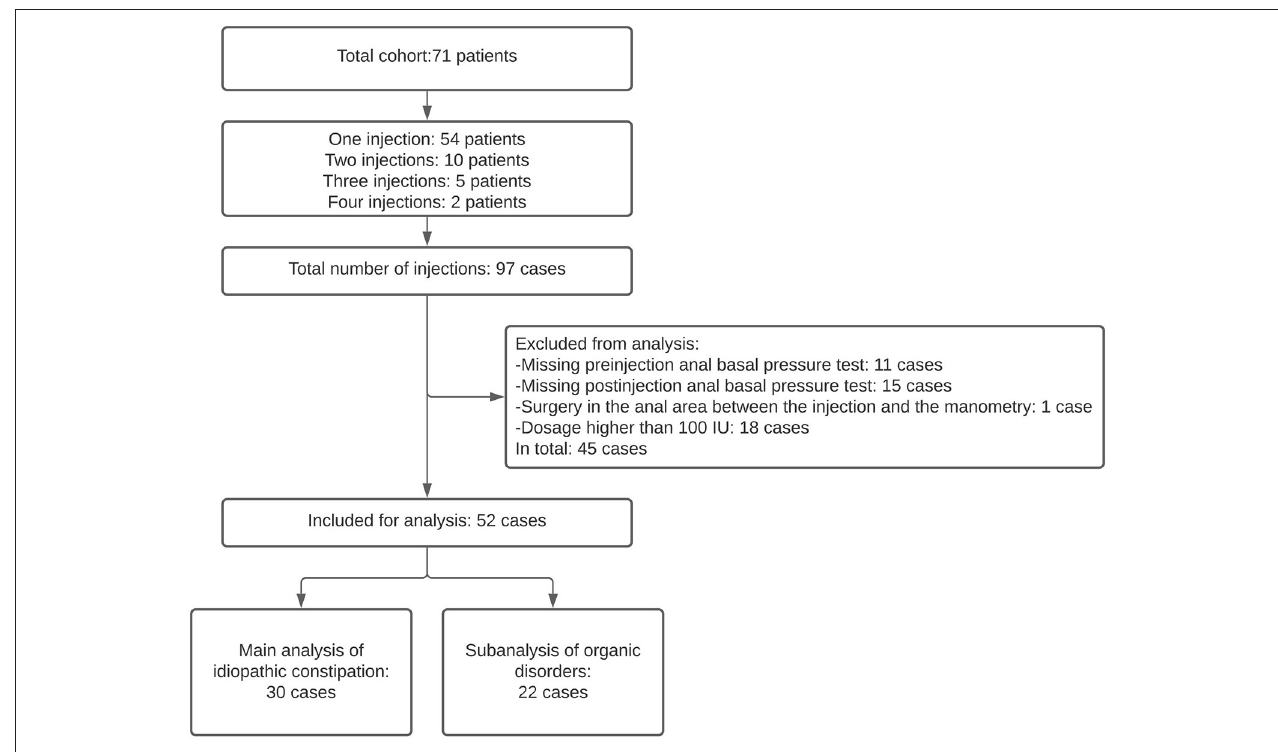
FIGURE 1 | Flowchart illustrating patients’ inclusion and exclusion